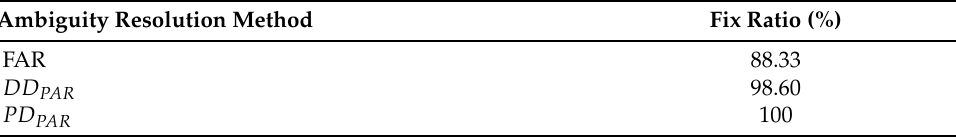
Figure 11. Horizontal (NE) position scatter plots along with the success rate 1 − P f for 12 h of real data (PERT-CUT0) only for fixed solutions. ( a ) DD-PAR performance analysis for 12 h of real data. ( b ) PD-PAR performance analysis for 12 h of real data. Table 2. Percentage of fixed solutions for every IAR method for 12 h of real